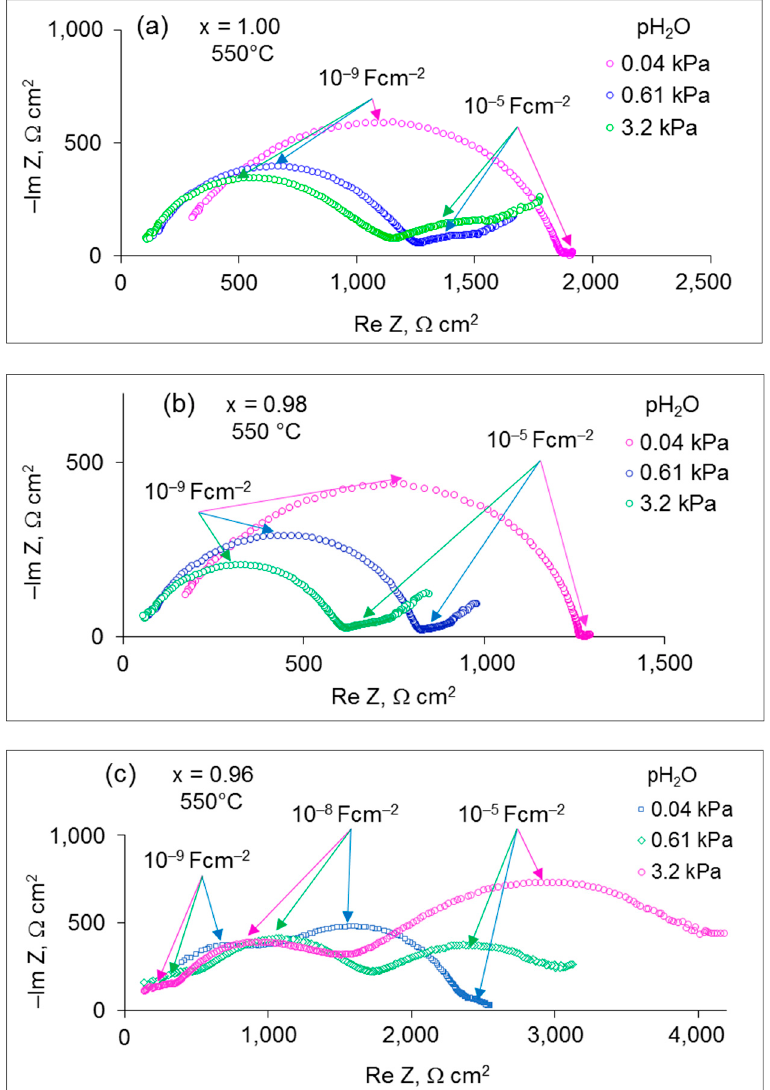
Figure 4. The impedance spectra for ( a ) x = 1.00, ( b ) x = 0.98 and ( c ) x = 0.96, measured under different pH 2 O at 550 °C.